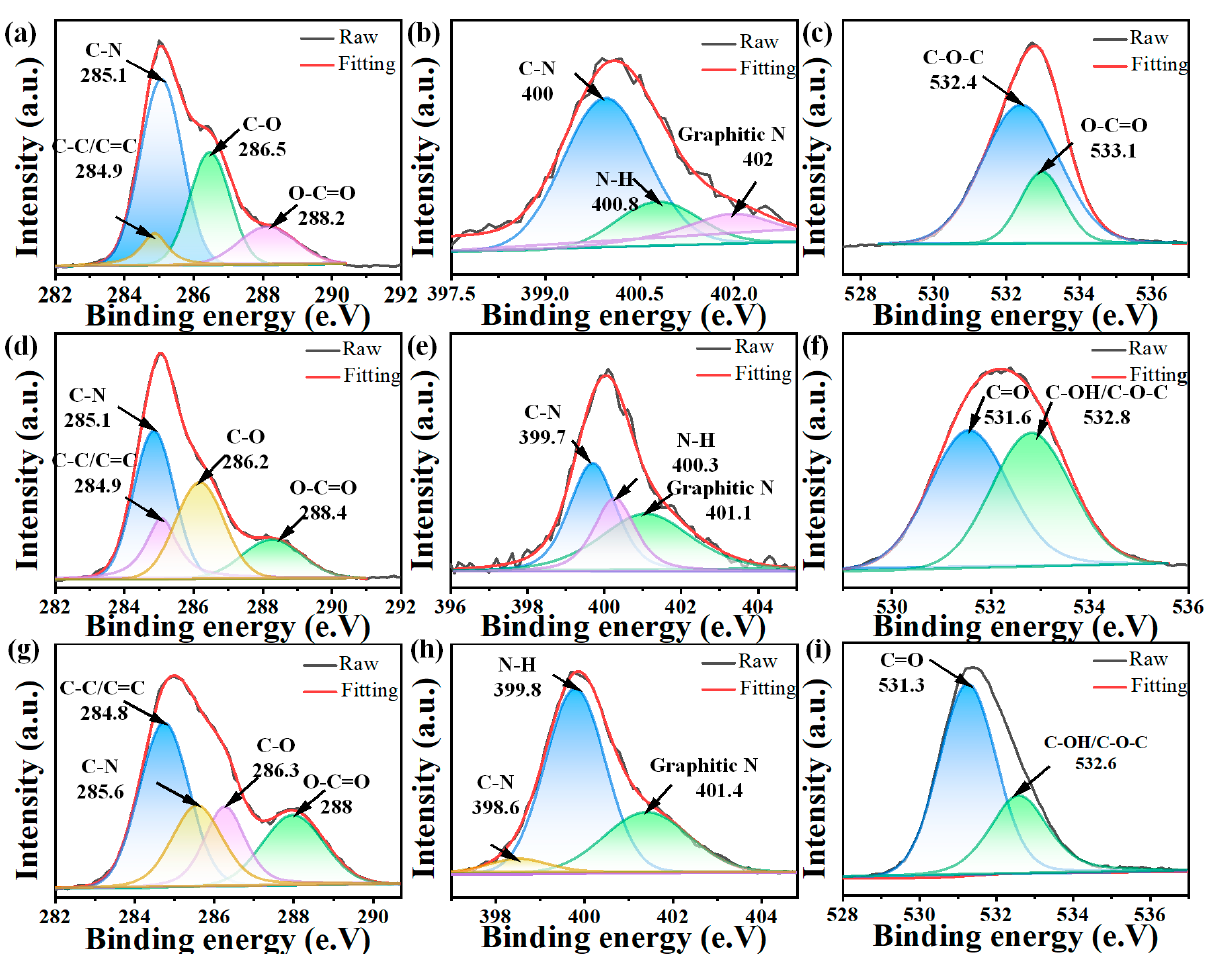
Figure 4. XPS high-resolution scans of the 140-CDs ( a ) C 1s ; ( b ) N 1s , and ( c ) O 1s . XPS high-resolution scans of the 160-CDs ( d ) C 1s , ( e ) N 1s , and ( f ) O 1s . XPS high-resolution scans of the 180-CDs ( g ) C 1s , ( h ) N 1s , and ( i ) O 1s .